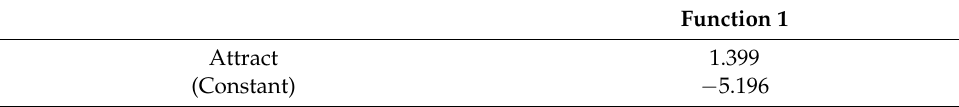
Table 8. Canonical discriminant function